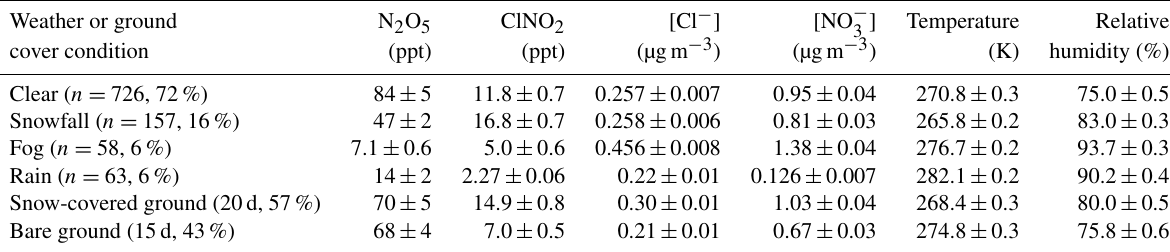
Table 1. Mean ( ± 95% confidence interval) mole ratios of N 2 O 5 and ClNO 2 , PM 2 . 5 Cl − and NO humidity during each type of weather event (clear, snow, fog, and rain) and ground cover (bare and snow-covered ground) measured across the entire campaign, between 18:00–08:00EST. The numbers of 30min periods ( n ) and percentages of nighttime periods classified as each weather condition are included in parentheses. Note that bare and snow-covered ground co-existed with the weather conditions, as discussed in Sect. 3.4. Averaged (30min) values are reported with 95% confidence